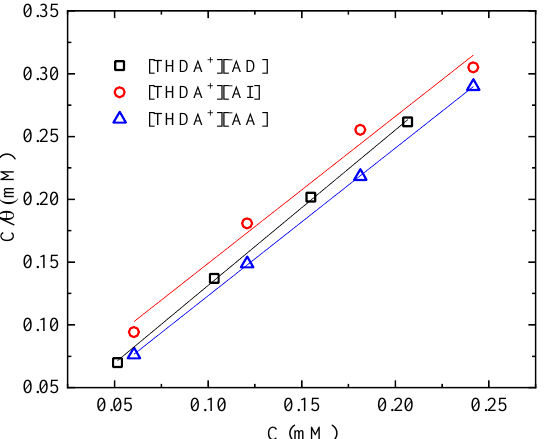
Figure 6. Langmuir adsorption isotherm for API X52 steel in 0.5 M HCl with ILs.